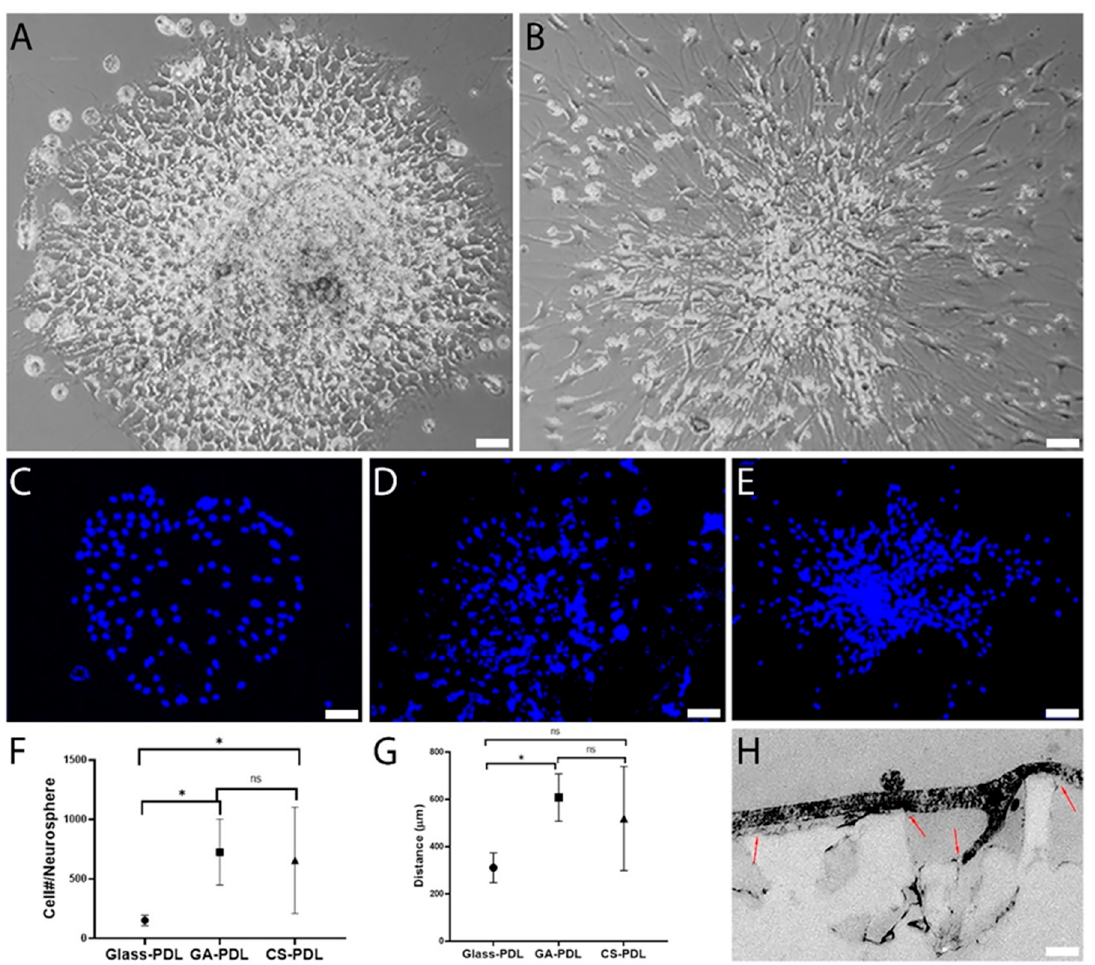
Figure 3. Enhanced neural cell migration on geological aragonite (GA-PDL) and PDL-coated coralline scaffolds (CS-PDL). 7-day-old cultures: ( A ) Glass-PDL. ( B ) CS-PDL. ( C – E ) DAPI of glass-PDL ( C ), GA-PDL ( D ), CS-PDL ( E ). ( F ) Number of migrating cells per neurosphere. Student’s t -test: Glass-PDL N = 5, Mean = 152.00 ± 44.67, GA-PDL N = 6, Mean = 725.50 ± 276.87, t 5.311 = − 4.996, P = 0.003, CS-PDL N = 6, Mean = 657.33 ± 445.11, t 5.121 = − 2.764, P = 0.039. GA-PDL vs. CS-PDL: t 10 = 0.319, P = 0.757. ( G ) Maximal migration distance. Student’s t -test: Glass-PDL N = 6, Mean = 310.00 ± 63.24, GA-PDL N = 3, Mean = 606.66 ± 100.16, t 7 = − 5.546, P = 0.001, CS-PDL N = 5, Mean = 518.00 ± 220.38, t 9 = − 2.226, P = 0.053. GA-PDL vs. CS-PDL: t 6 = 0.642, P = 0.544. ( H ) TEM of a neural cell interacting with the tips of CS-PDL grains (arrows). Scale: ( A , B )-50 μ m; ( C , D )-30 μ m. (* P < 0.05; ns = non-significant).